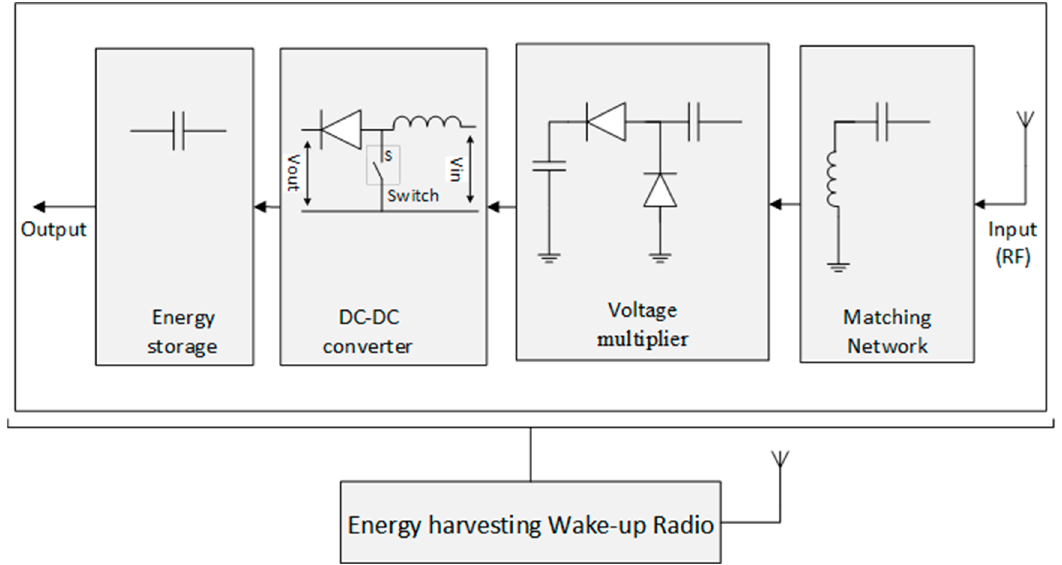
Figure 2. Breakdown of the components for the energy harvesting circuit.